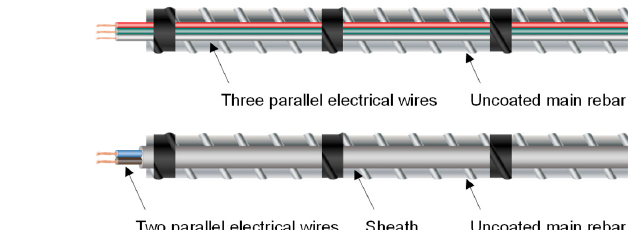
Figure 3. Transmission lines configured with: ( a ) single electrical wire and uncoated main rebar (D1 and T1), ( b ) single electrical wire and epoxy-coated main rebar (D2 and T2), ( c ) two parallel electrical wires (D3 and T3), ( d ) three parallel electrical wires (D4 and T4), and ( e ) two parallel electrical wires wrapped in a sheath (D5 and T5).